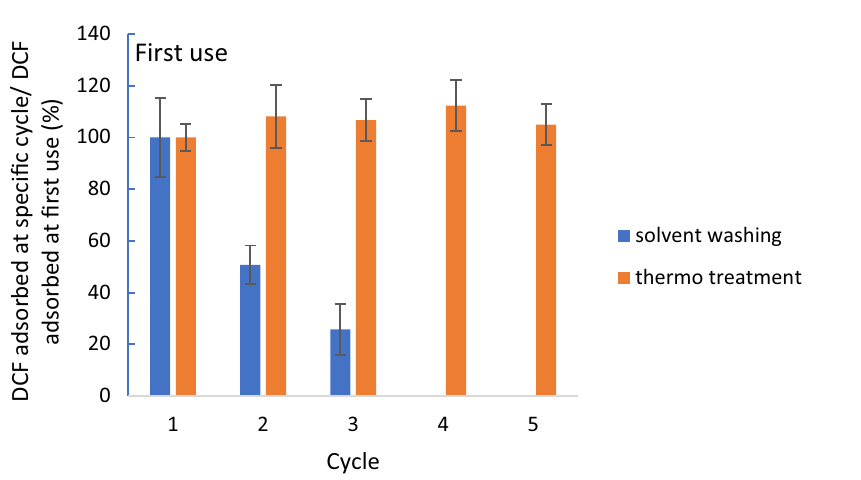
Figure 10. Performance of material after recovery treatment. Recovery performed by solvent washing with NaOH 0.2 M for 3 h at stirring speed of 800 rpm and thermo treatment at 105 °C for 2 h and 200 °C for 4 h. Adsorption step was done by using DCF 20 mg L −1 , pH 1, stirring speed of 650 rpm, contact time of 10 min and 10 mg of adsorbent material. Standard deviation of each experimental data is also